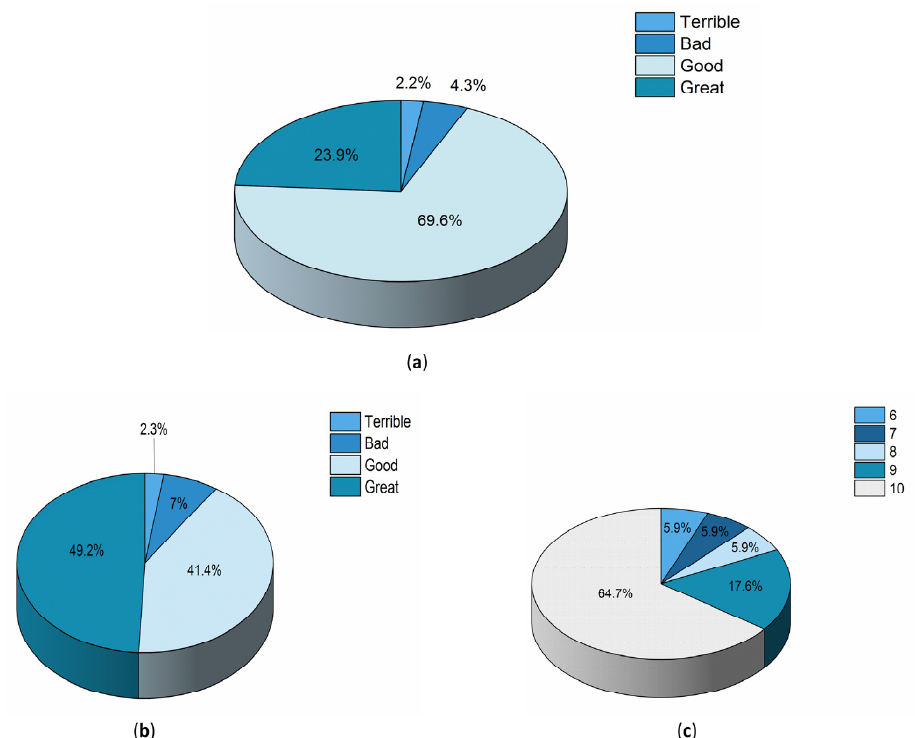
Figure 9. Analysis of the perception of patients and professionals regarding the use of the bubble device: ( a ) perception of patients regarding the experience with the bubble device, classifying it as “terrible”, “bad”, “good”, and “great”; ( b ) perception of health professionals regarding the usefulness of the bubble to support the treatment of diagnosed patients, classifying it as “terrible,” “bad,” “good”, and “great”; and ( c ) perception of professionals responsible for cleaning the device as to the level of ease of cleaning it, considering a scale from 1 to 10.